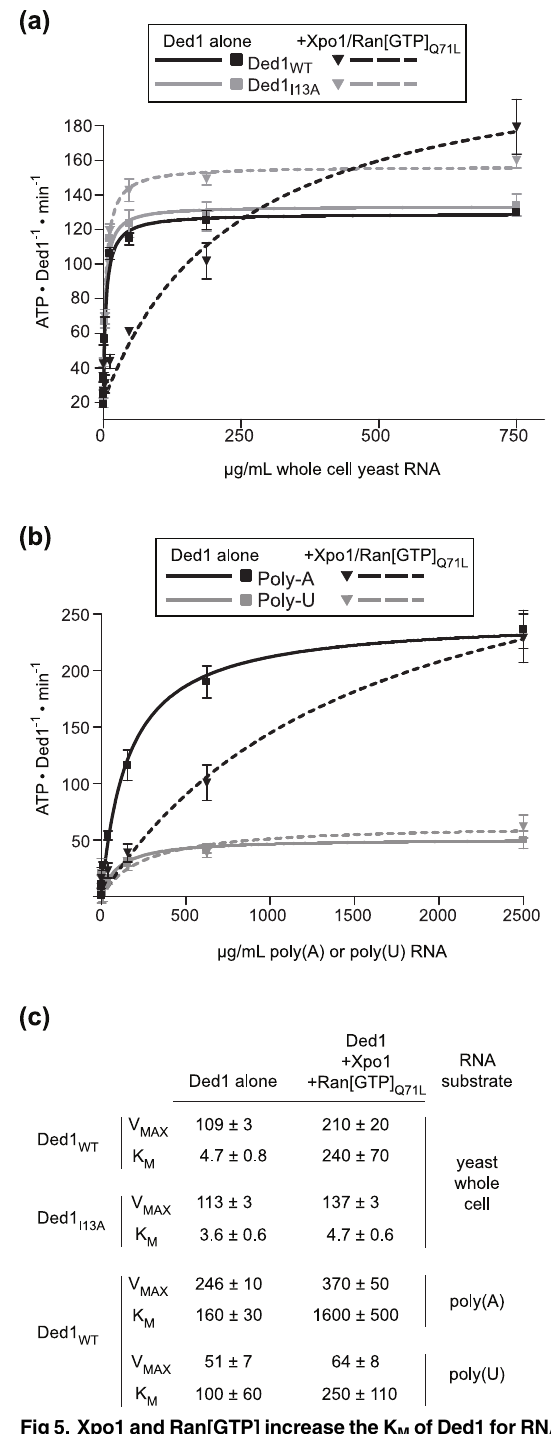
Fig 5. Xpo1 and Ran[GTP] increase the K M of Ded1 for RNA. (a) Whole cell yeast RNA titrations in the presence of Xpo1 and Ran[GTP]. Rates of ATP hydrolysis are plotted for 500 nM wild-type Ded1 (black squares) and Ded1 I13A (gray squares) in the presence of 0, 0.18, 0.7, 2.9, 11.7, 46.9, 187.5, 750 μ g/mL whole cell yeast RNA. The same titration series for wild-type Ded1 (black triangles) and Ded1 I13A (gray triangles) was conducted in the presence of 11 μ M Xpo1 and 13 μ M Ran[GTP] Q71L . Michaelis-Menten fits are plotted for Ded1 (solid black line) and Ded1 I13A (solid gray line) alone and with Xpo1/Ran[GTP] (dotted black and gray lines, respectively). (b) Michaelis-Menten plots for Ded1 in the absence or presence of Xpo1 and